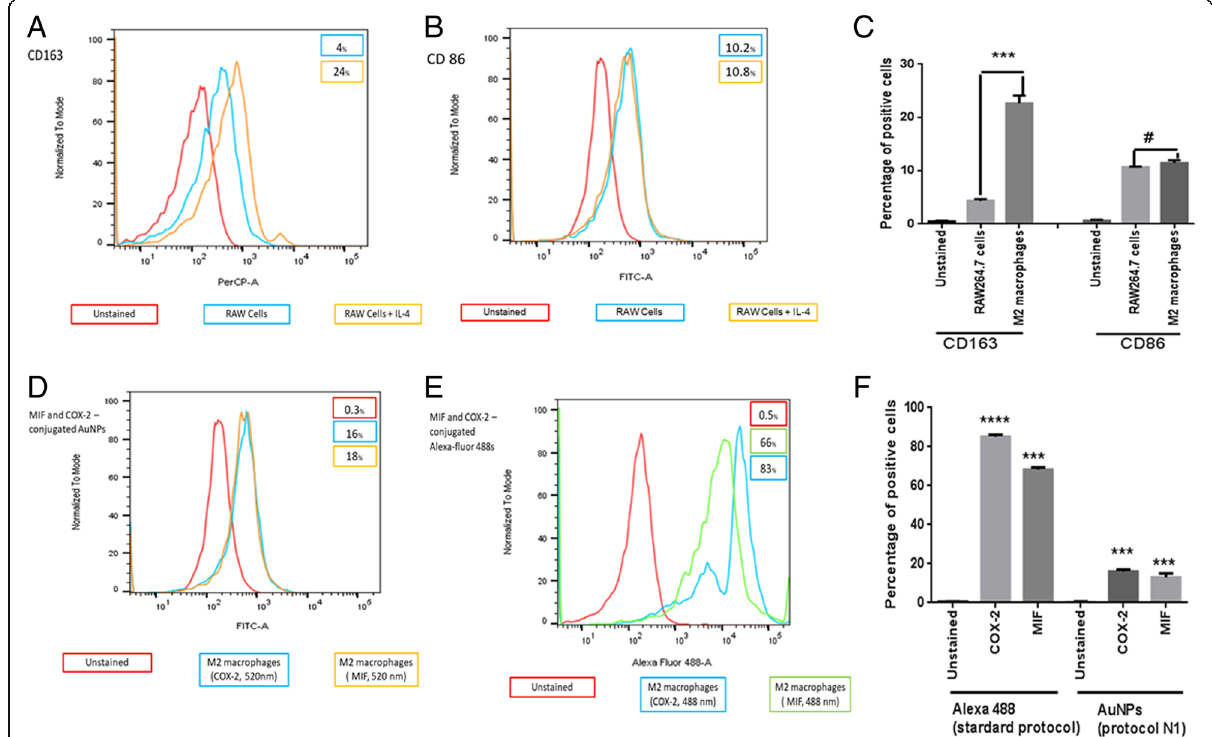
Fig. 5 COX-2 and MIF antibody-conjugated gold nanoparticles (AuNPs) have high affinity on the surface of M2 macrophages. a – c RAW 264.7 cells were stimulated with IL-4 (20 ng/ml) for 24 h, followed by flow cytometry analysis to quantify the amount of CD163, an M2 macrophage marker, and CD86, an M1 marker. d , f Either COX-2 and MIF antibody-conjugated gold nanoparticles or e , f ALEXA 488 showed higher fluorescence intensity in M2 macrophages when compared to unstained samples. Data are expressed as mean ± SD, # p > 0.05, *** p < 0.001, p < 0.0001. Representative flow data shown are from experiments independently performed at least three